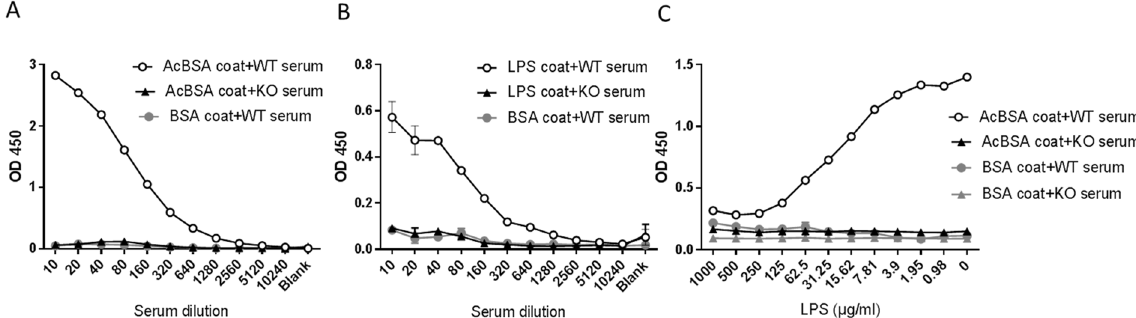
Figure 1. Serum ficolin-A binds to LPS in vitro . ELISA plates were coated with of BSA (negative control), the ficolin-A ligand AcBSA (positive control) or LPS (all 5 µ g/ml). In A and B , serial dilutions of mouse serum (WT or ficolin KO) were added to the plates and ficolin-A was detected with an anti-ficolin-A antibody. In C , mouse serum (WT or ficolin KO) was diluted 1:50 and pre-incubated with serial dilutions of LPS for 2 h. Subsequently, the samples were added to plates coated with AcBSA or BSA and ficolin-A was detected with an anti-ficolin-A antibody. All graphs show mean ± SEM of duplicate wells and are representative of three independent